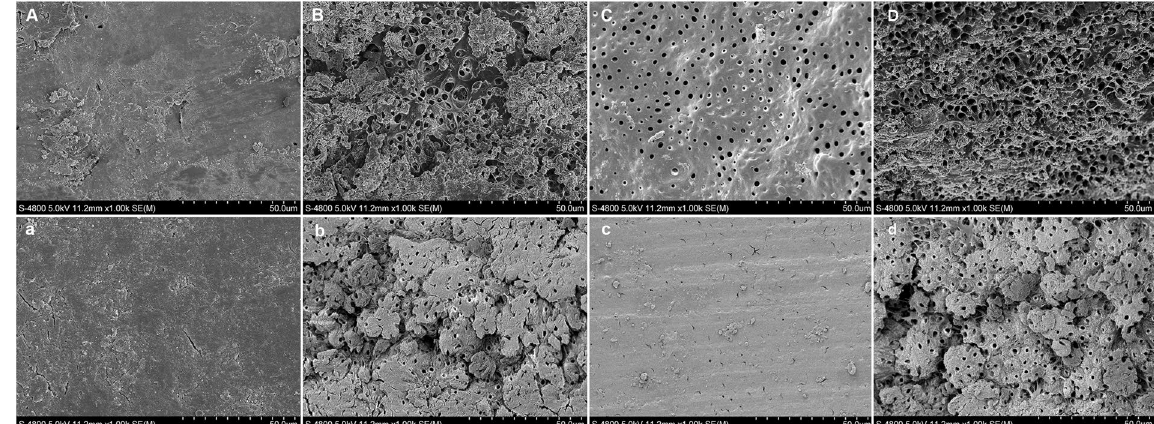
Figure 4. SEM photomicrographs of post space surfaces after different treatments ( × 1,000). In BC group ( A and a ), the post space surfaces were covered by thick smear layers. In NA group ( B and b ) and NE group ( D and d ), large amount of smear layer could still be observed on the dentin surfaces with small part of dentinal tubules being opened. In NEG group ( C and c ), the surfaces of post spaces were cleaner with only partial of smear layer remained. Higher degree of smear layers could be detected in apical region than in coronal region ( A–D ).